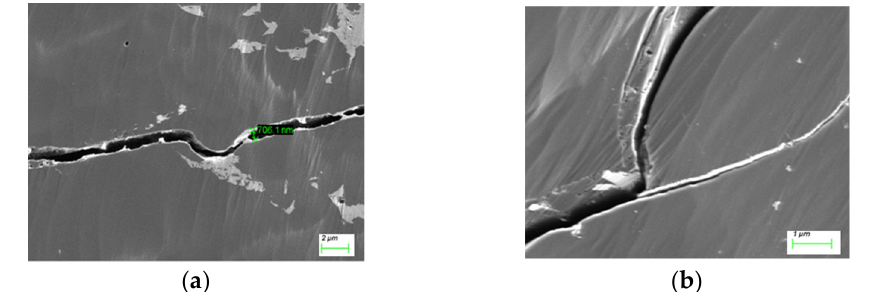
Figure 2. Examples of SEM images of rough-walled tortuous single-fracture ( a ) and Y-shaped fracture junction ( b ) in coals .